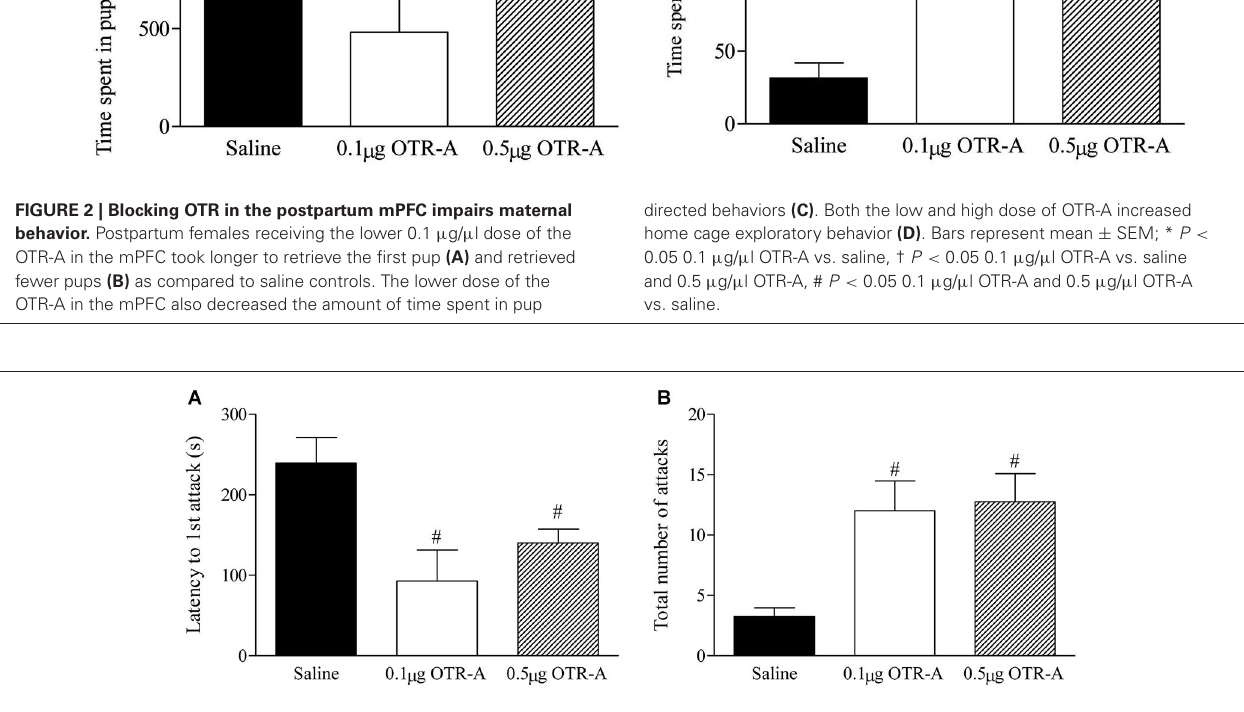
FIGURE 3 | Blocking OTR in the postpartum mPFC enhances maternal aggression. Postpartum females infused with either the lower 0.1 µ g/ µ l or higher 0.5 µ g/ µ l dose of the OTR-A in the mPFC displayed a significant